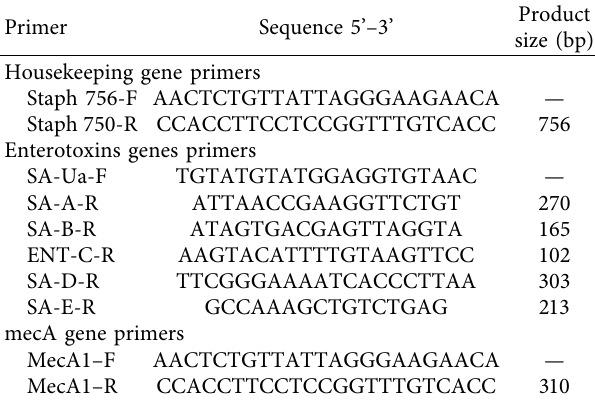
Table 2: Primers used for detection of S. aureus housekeeping gene, enterotoxins, and mecA